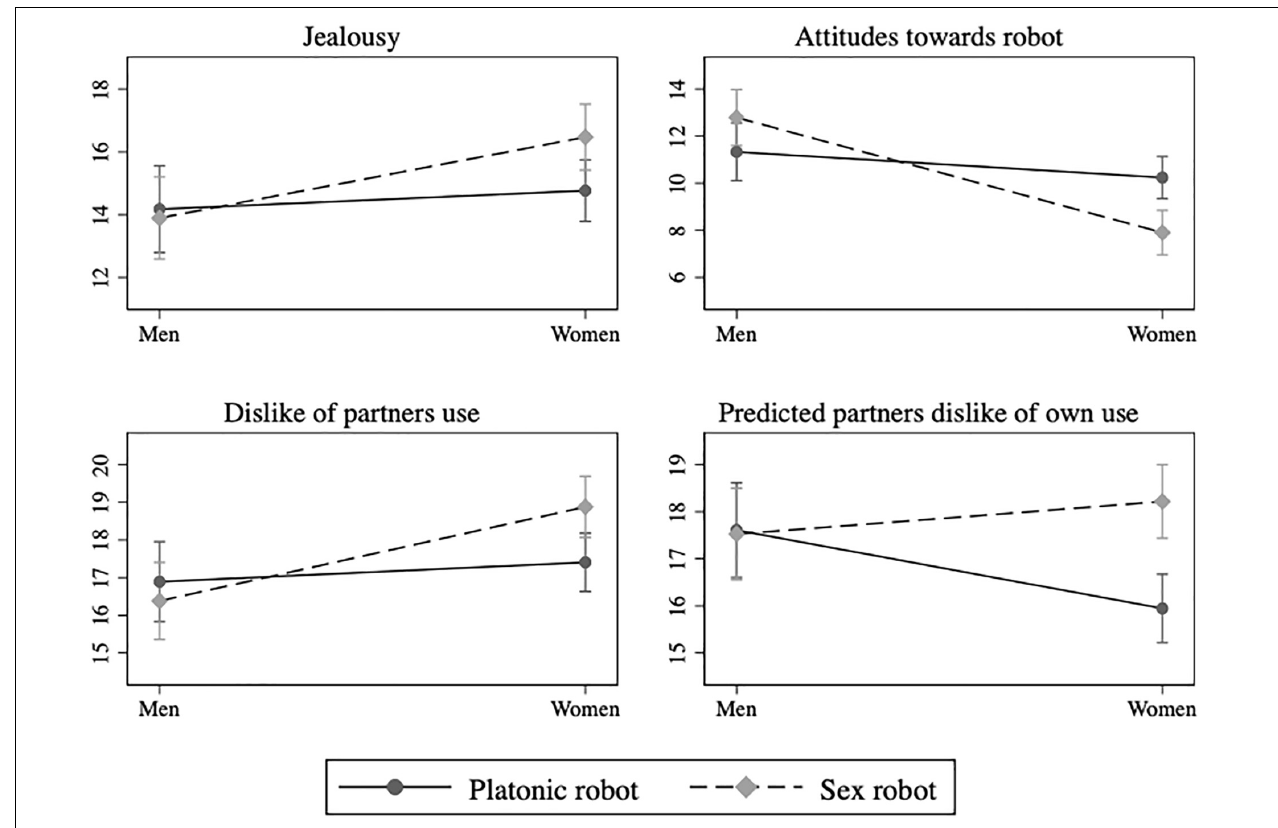
FIGURE 1 | Interaction effects of gender and experimental condition on dependent